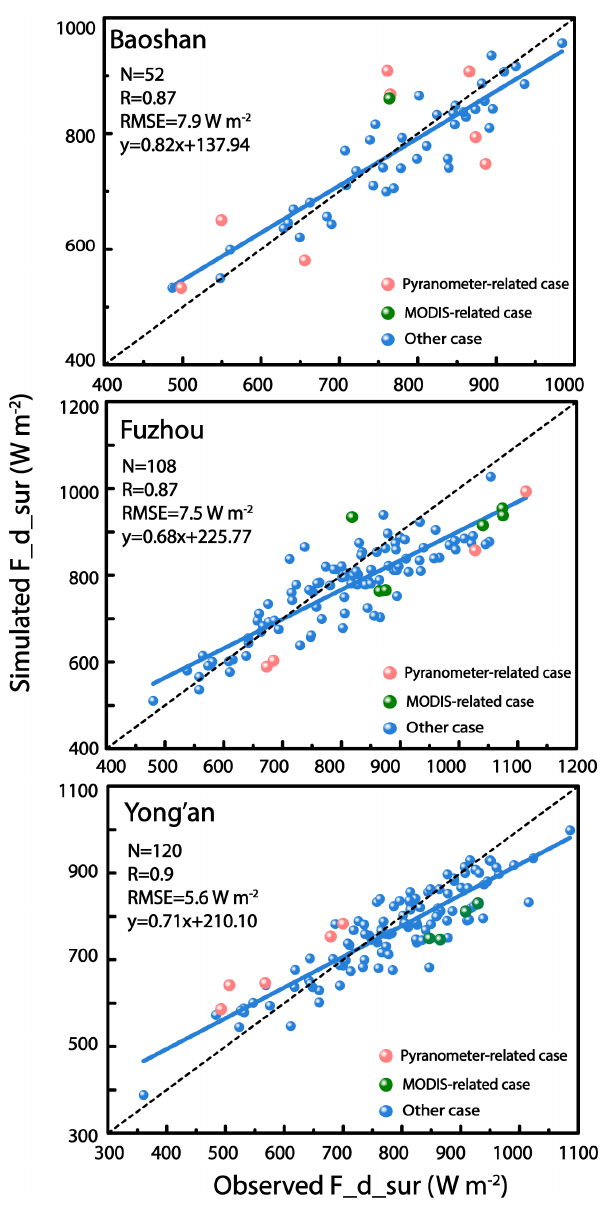
Figure 5. The scatter plots between observed F_d_sur by pyra- nometers and simulated F_d_sur by SBDART in Baoshan, Fuzhou, and Yong’an. The blue line is the fitting curve and the dashed line represents y = x . The red dots denote the specific case in which the pyranometer captures the fluctuation of F_d_sur by clouds during 1h. The olive green dots denote the specific case in which the site is completely covered by clouds, deduced from a MODIS true color map composed of channels 1, 4, and 3. The blue dots represent the other ordinary